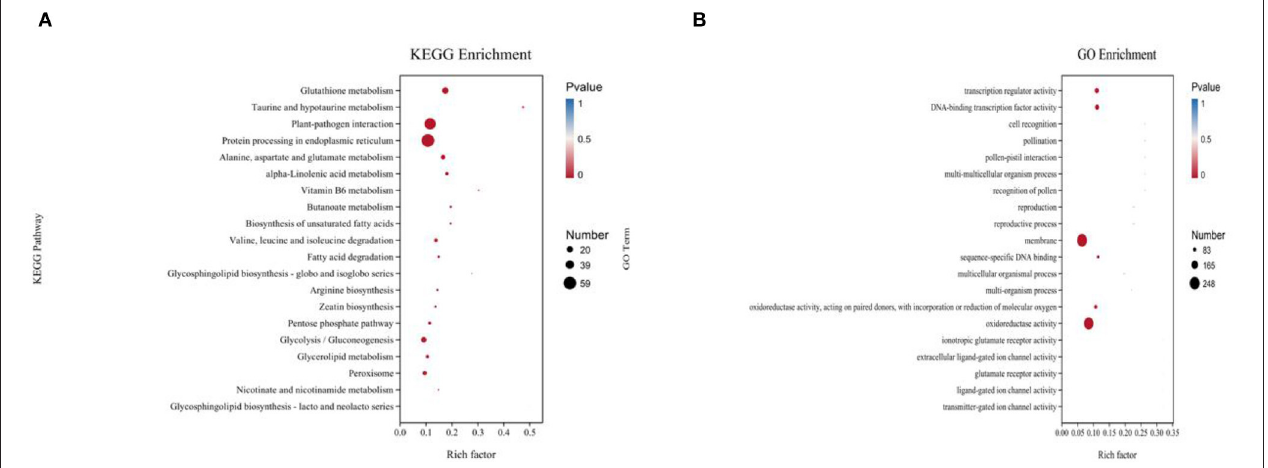
FIGURE 3 | Gene ontology (GO) (A) and KEGG pathway-rich analysis (B) . Based on the GO-rich and KEGG results, the extent of richness is measured by the rich factor, false discovery rate (FDR) values, and the number of genes that were collected into this GO term or KEGG pathway. Rich factor refers to the ratio of the number of different genes collected in the GO term or KEGG pathway to the number of genes annotated.